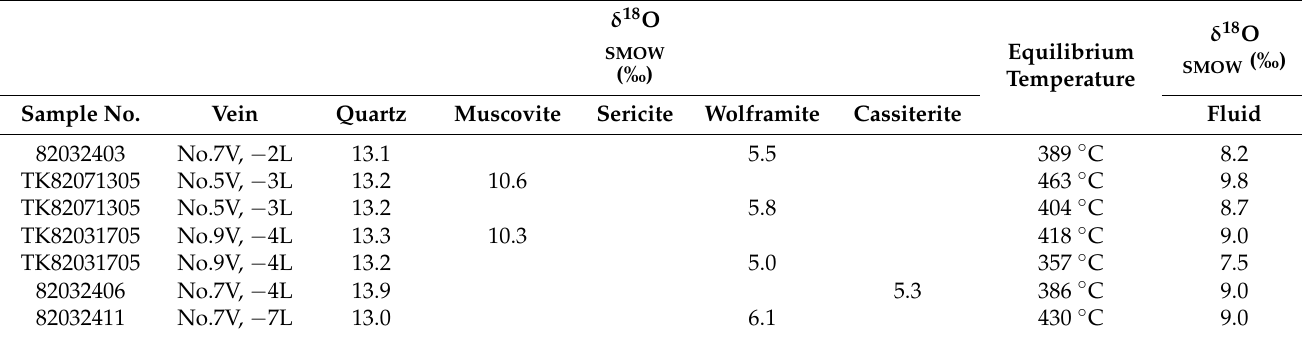
Table 5. Oxygen isotope ratios of mineral pairs from the Takatori deposit.